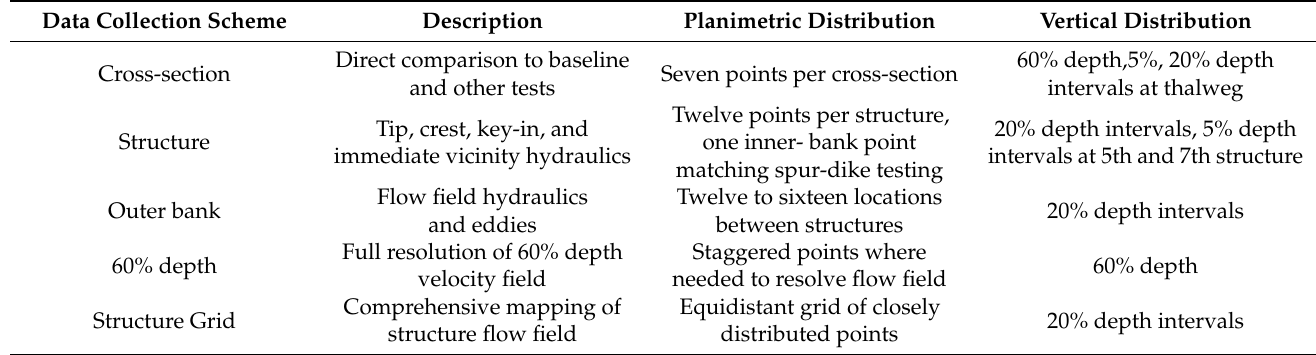
Table 4. Physical Model Bend